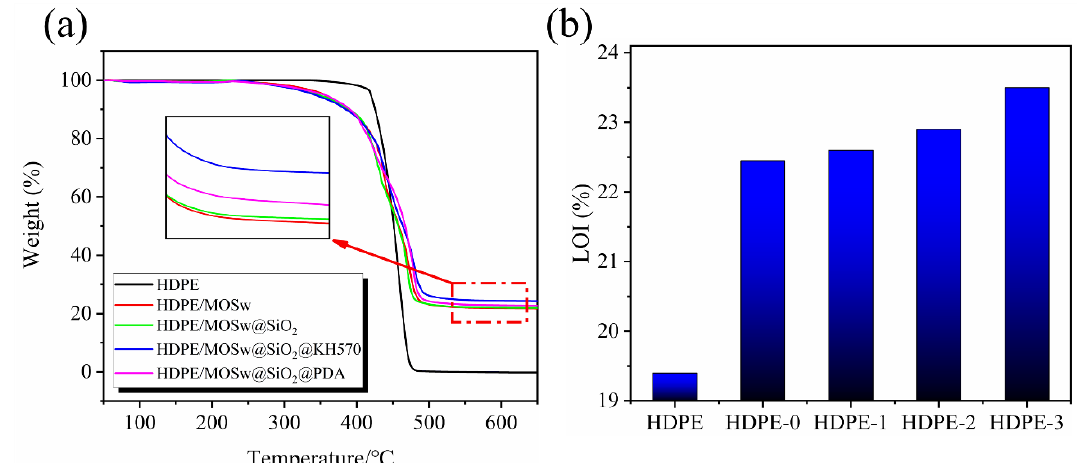
Figure 9. TGA curves ( a ) and LOI data diagram ( b ) of HDPE, HDPE-0 (HDPE/MOSw), HDPE-1 (HDPE/MOSw@SiO 2 ), HDPE-2 (HDPE/MOSw@SiO 2 @KH570) and HDPE-3 (HDPE/MOSw@SiO 2 @PDA) composites before and after modification. MgSO 4 ·5Mg(OH) 2 ·3H 2 O → MgSO 4 ·5Mg(OH) 2 +3H 2 O (287 °C ~322 °C) (1-1); MgSO 4 ·5Mg(OH) 2 → MgSO 4 + MgO+5H 2 O (368 °C ~424 °C) (1-2); MgSO 4 → MgO+SO 3 ( ＞ 800 °C) (1-3) Table 3. LOI and parameters of thermal stability for neat HDPE, HDPE/MOSw, HDPE/ MOSw@ SiO 2 , HDPE/MOSw@SiO 2 @KH570 and HDPE/MOSw@SiO 2 @PDA. Sample T onset (°C)